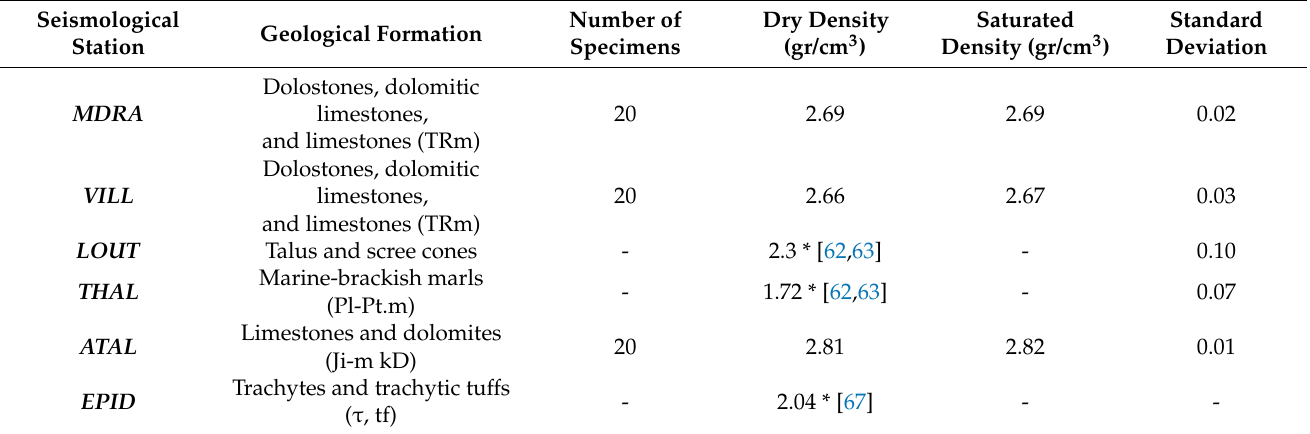
Table 2. Density values of the geological formations of the investigated areas. The density values marked with an asterisk were obtained from the indicated literature